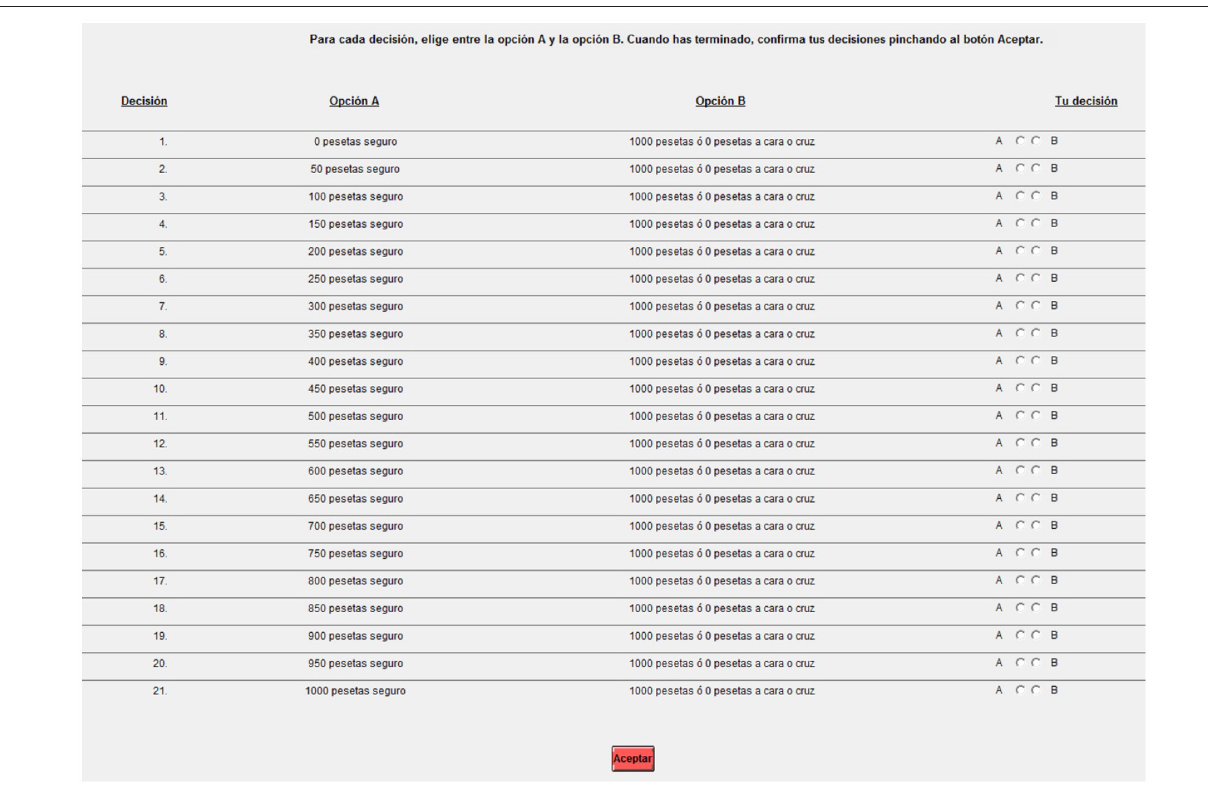
FIGURE 2 | User interface for the multiple price list in projects 2–5.